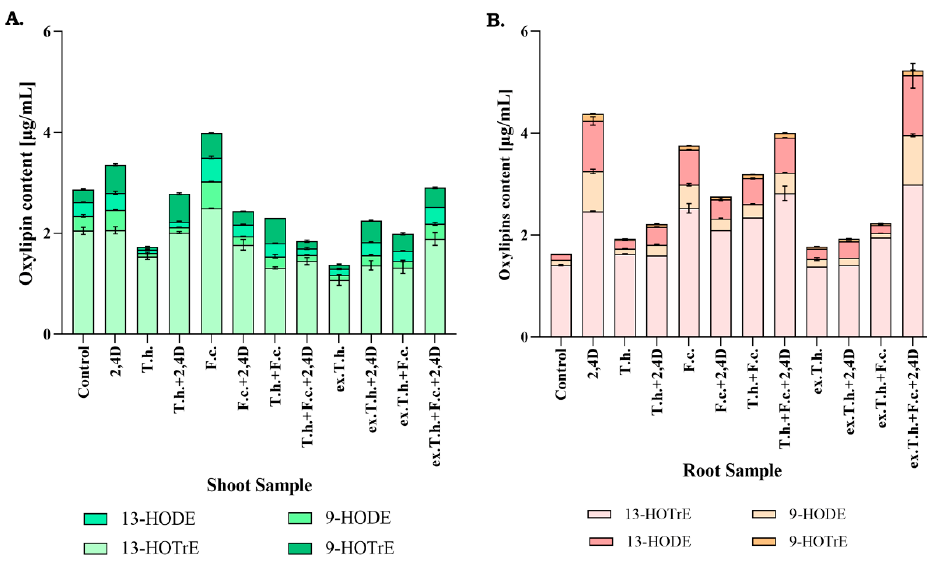
Figure 5. Relative oxylipin amounts in the shoots ( A ) and roots ( B ) measured after 7 days of cultivation (T.h.— T. harzianum -inoculated wheat seeds; F.c.— F. culmorum -inoculated wheat seeds; ex.T.h.— T. harzianum extracellular metabolite-treated wheat seeds). Data represent means ± SE; the